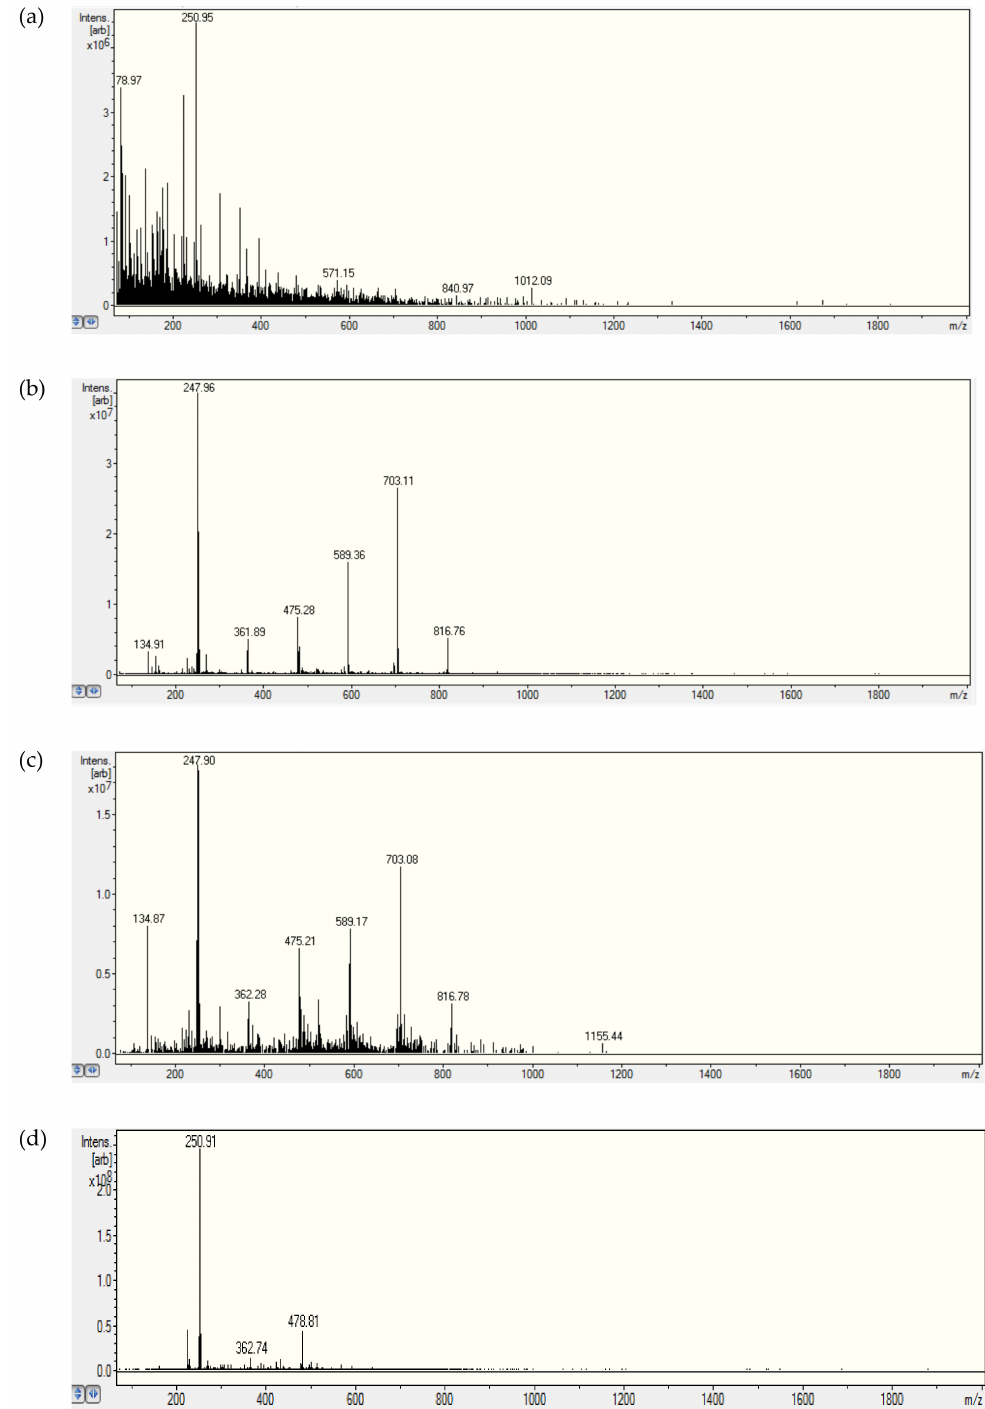
Figure 1. Electrospray ionization-ion trap mass spectronomy (ESI-ITMS) analyses: ( a ) Millipore water, ( b ) bisphenol A (BPA) (100 µ g / mL), ( c ) BPA (100 µ g / mL) + TiO 2 nanopowder (414 µ g / mL), ( d ) BPA (67 µ g / mL) + TiO 2 nanopowder (276 µ g / mL) + sodium formate (50 µ g /